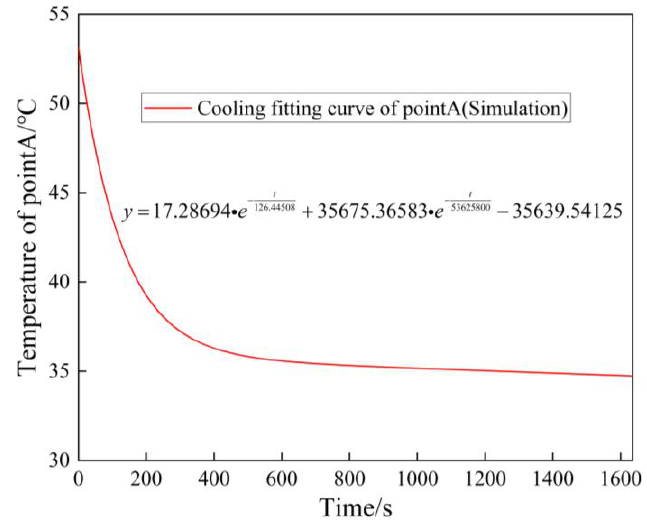
Figure 25. Cooling fitting curve of pointA.